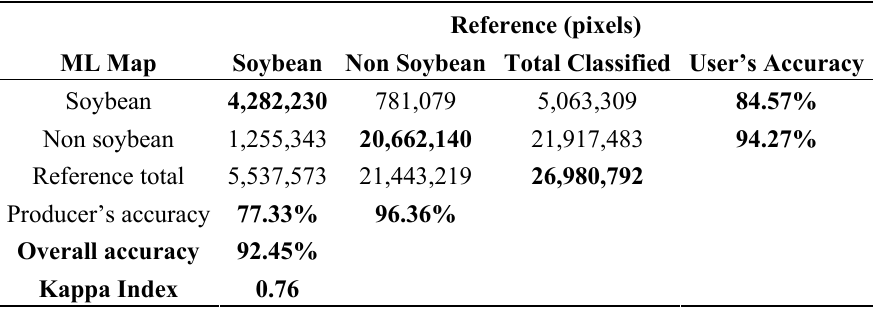
Table 3. Confusion matrix from the comparison between ML map and the [3]